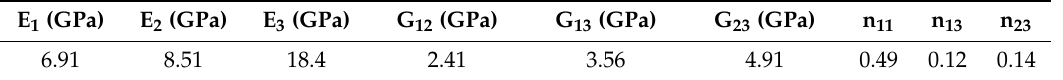
Table 1. Main mechanical properties of the cortical bone [51].